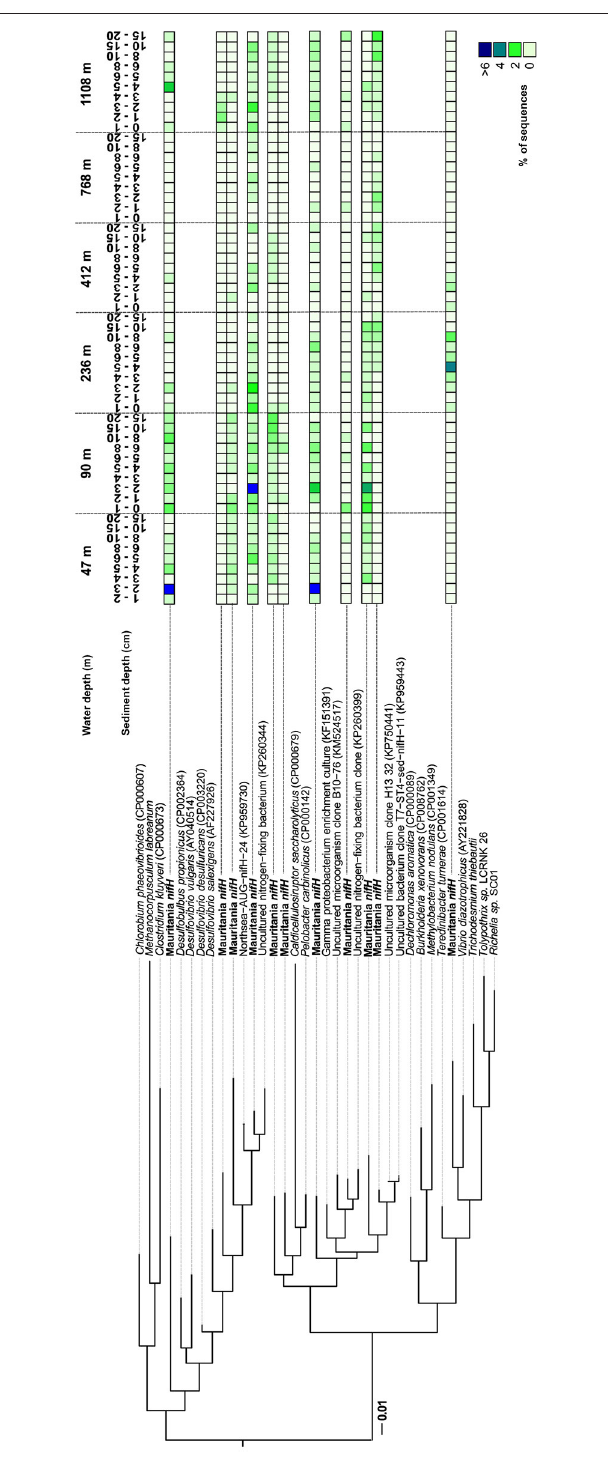
FIGURE 4 | Phylogenetic tree of expressed nifH genes based on the analysis of ∼ 8000 sequences and respective abundance from the total data set (see legend of the color code on the right). The six sampling stations are shown with the corresponding sediment depth (cm). The scale bar represents 10% estimated sequence